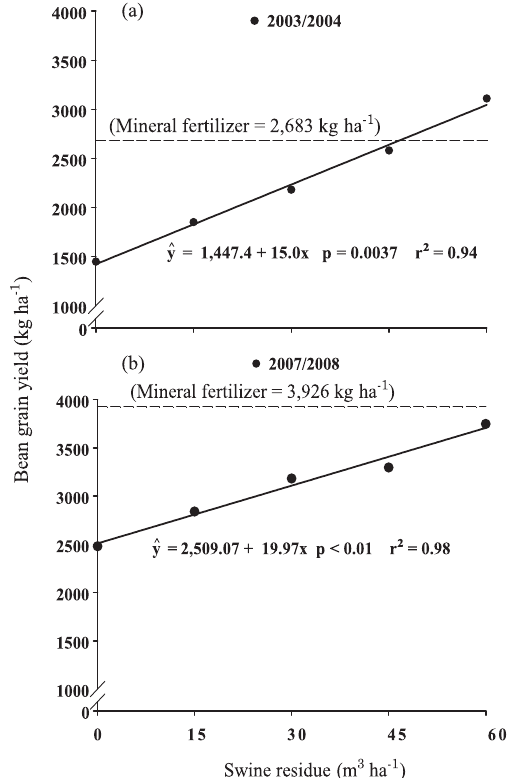
figure 4. common bean grain yield (kg ha -1 ) as affected by the application of 0, 15, 30, 45, and 60 m 3 ha -1 swine residue in the growing seasons 2003/2004 and 2007/2008 (a) and compared to mineral fertilizer